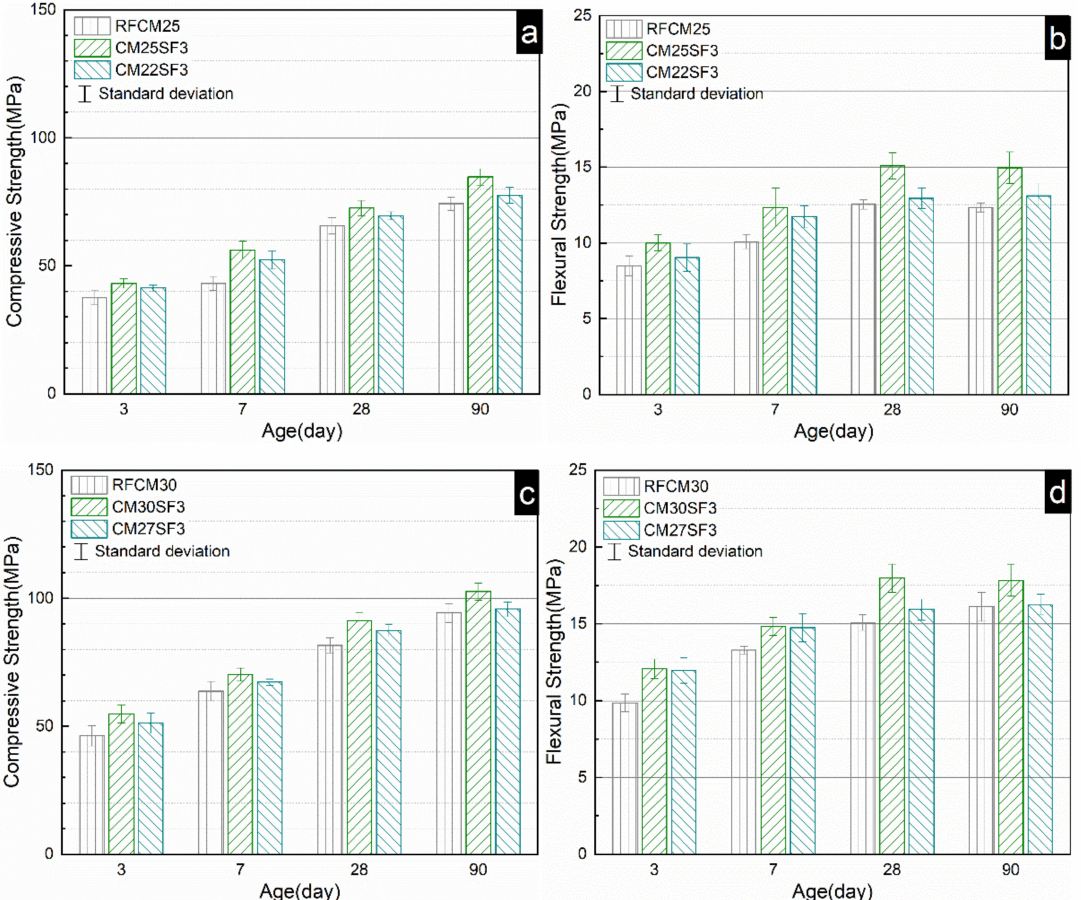
Figure 8. Compressive strength ( a , c ) and flexural strength ( b , d ) of limestone powder-superfine Portland cement–silica fume